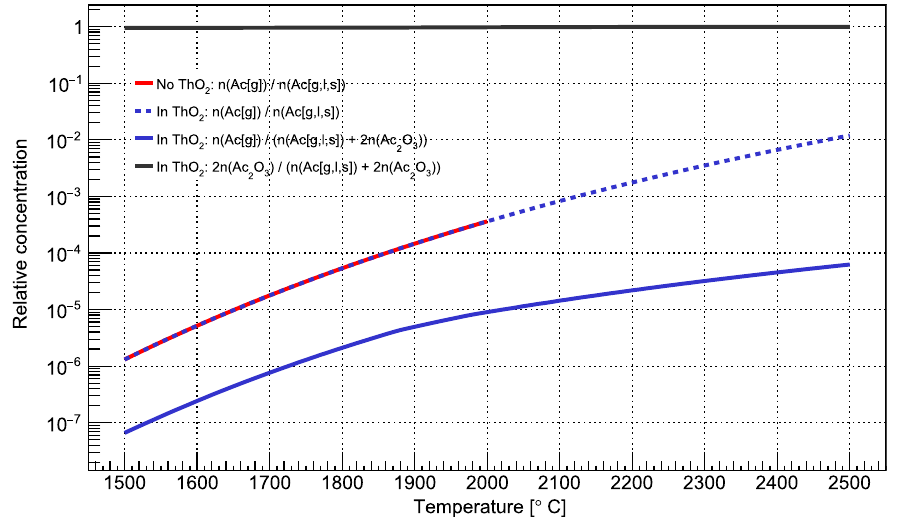
Figure 5. The relative equilibrium concentration of Ac species in a ThO 2 environment and in a pure environment. Most Ac is locked up in Ac 2 O 3 , while the equilibrium gas phase concentration Ac(g) increases exponentially with temperature, but at different rates. The simulations also account for the liquid and solid phases, labeled (l) and (s) respectively.